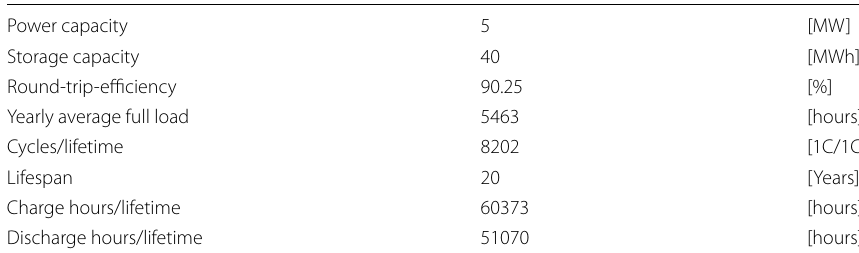
Table 2 BESS characteristics Power